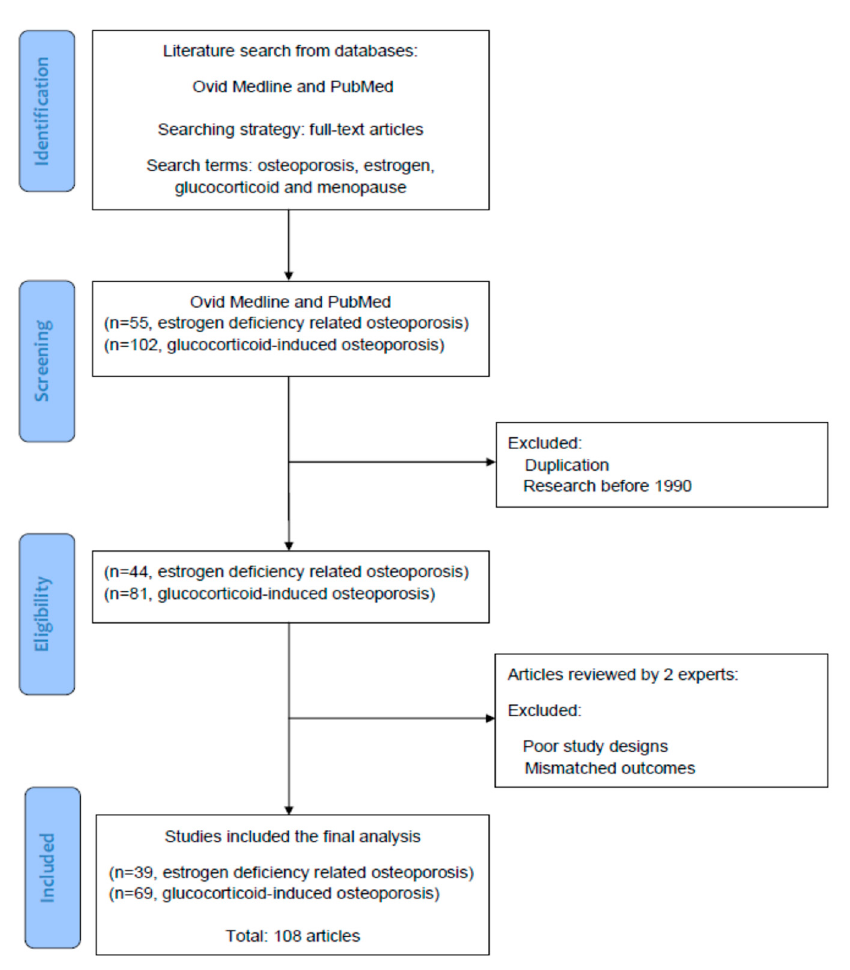
Figure 1. The diagram of article selection, screening, and inclusion from the literature .